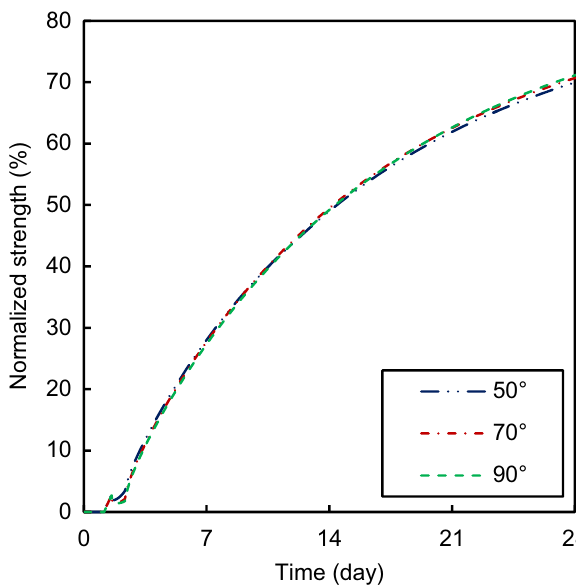
Fig. 18 Effect of inclination angle on changes to CPB strength at the bottom of CPB mass.